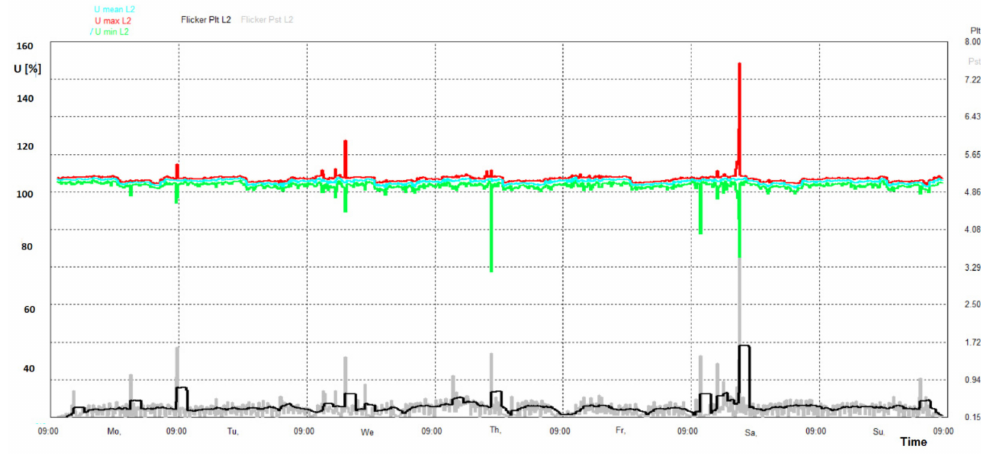
Figure 14. Voltage, long-term and short-term flicker indicator P lt , P st measured ar Point B. DC electric traction mainly causes distortion of the supply voltage. Figure 15 shows the spectrum of voltage and current harmonics measured in point B. The reduced THD_U coefficient was recorded during one week of measurements. The spectrum of voltage and current harmonics presented in Figures 15 and 16 concerns the moment when THD_U reached the highest value (THD_Umax) during the week of measurements. In the spectrum of current and voltage, there are higher harmonics characteristic for the load supplied from a six-pulse rectifier. The THD_U values recorded during the week of measurements are characterized by high variability. By analyzing the weekly nature of THD_U changes, a superposition of disturbances generated by the traction substation and other receivers connected to the power system can be observed.